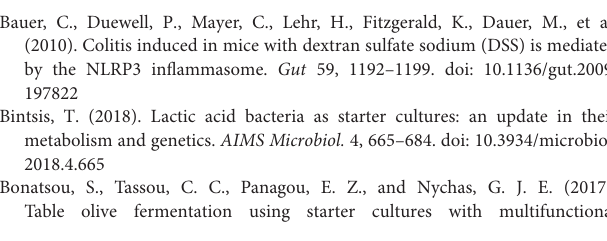
Table olive fermentation using starter cultures with multifunctional